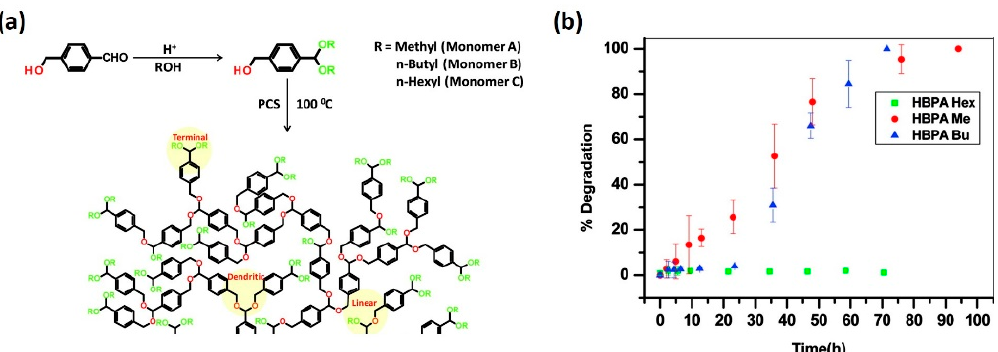
Figure 8. Hydrophobic modification in tuning the degradation rate of hyperbranched polyacetals. ( a ) Structure and synthetic route of hyperbranched polyacetals. Monomers with different hydrophobic substituents (methyl, butyl, and hexyl) were used in the preparation of three model branched polyacetals. ( b ) Branched polyacetal with least hydrophobic methyl groups showed fast degradation within 10 h, whereas polyacetal with most hydrophobic hexyl group showed almost no significant degradation after 4 days. Reproduced with permission from Saptarshi Chatterjee and S.